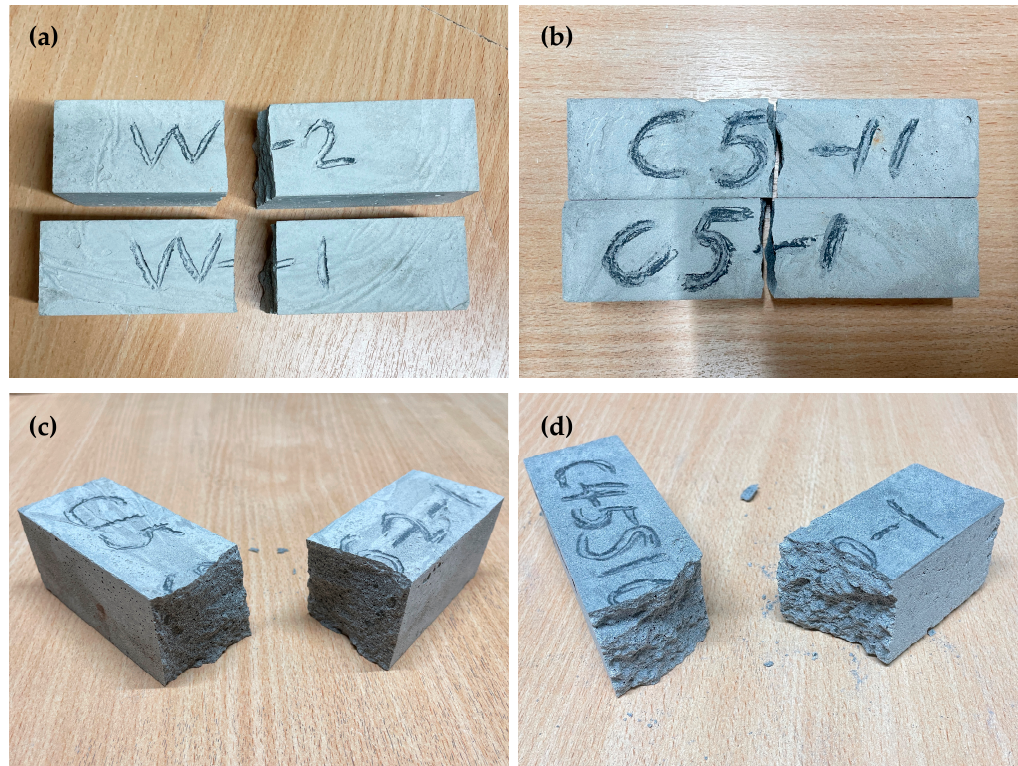
Figure 5. Degradation of representative specimens after the flexural test: ( a ) RS; ( b ) C5S0; ( c ) C15S2; ( d ) C45S10.